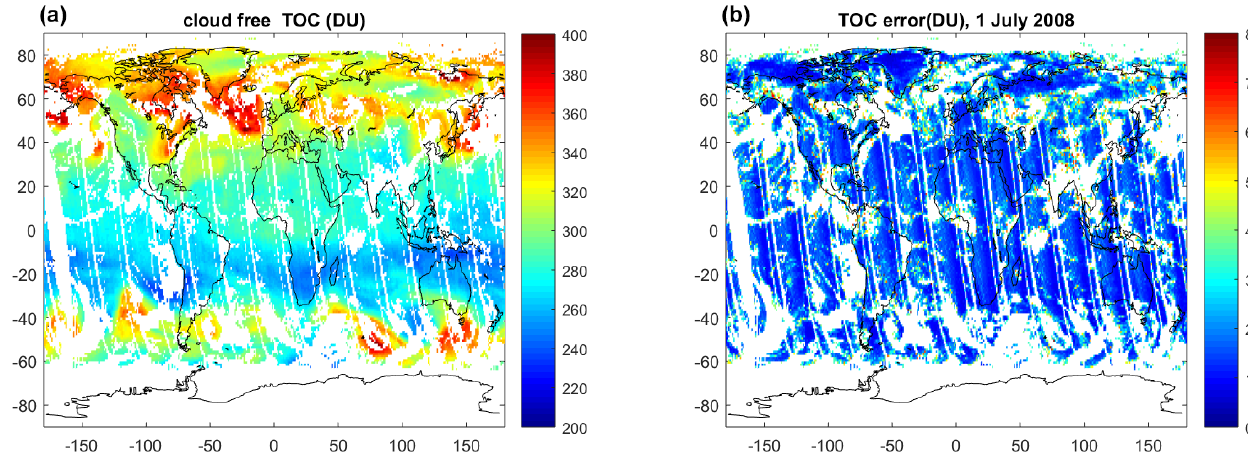
Figure 5. OMI Level 3 total ozone column data (a) and random uncertainty (b) for 1 July 2008.